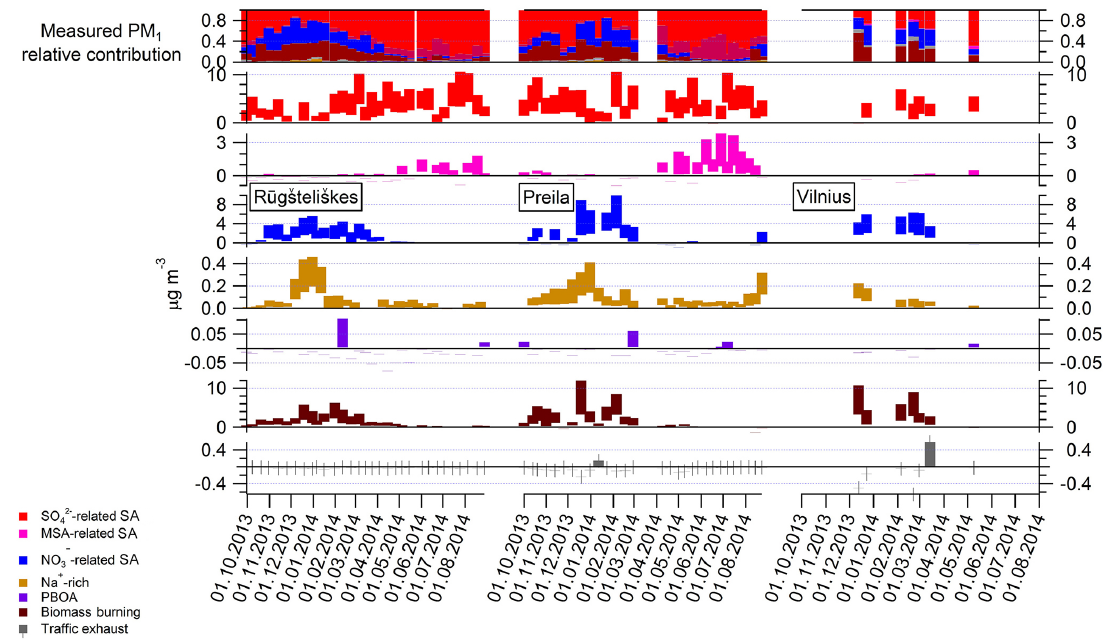
Figure 5. PM 1 marker source apportionment: factor time series and relative contributions. Shaded areas indicate uncertainties (standard deviation) of 20 bootstrap